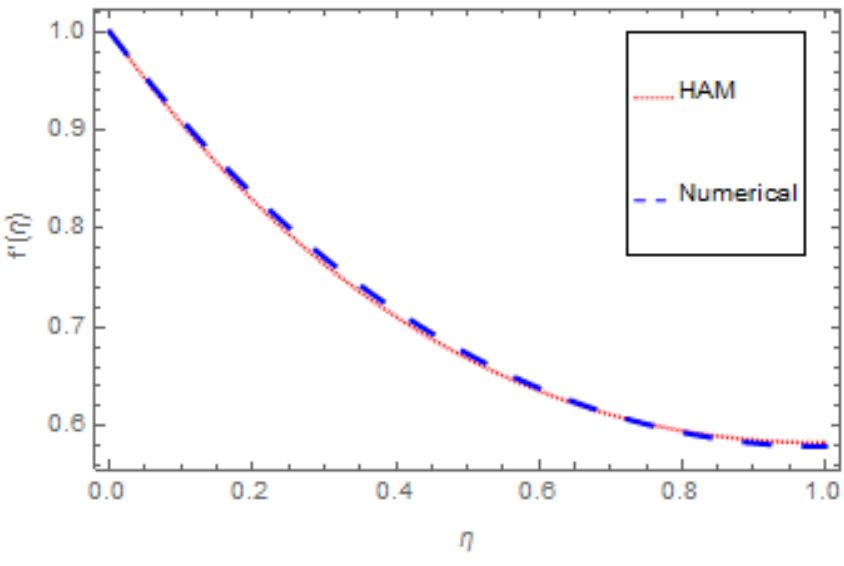
Figure 13. Comparison graph of HAM and numerical solution for f ( η ) .